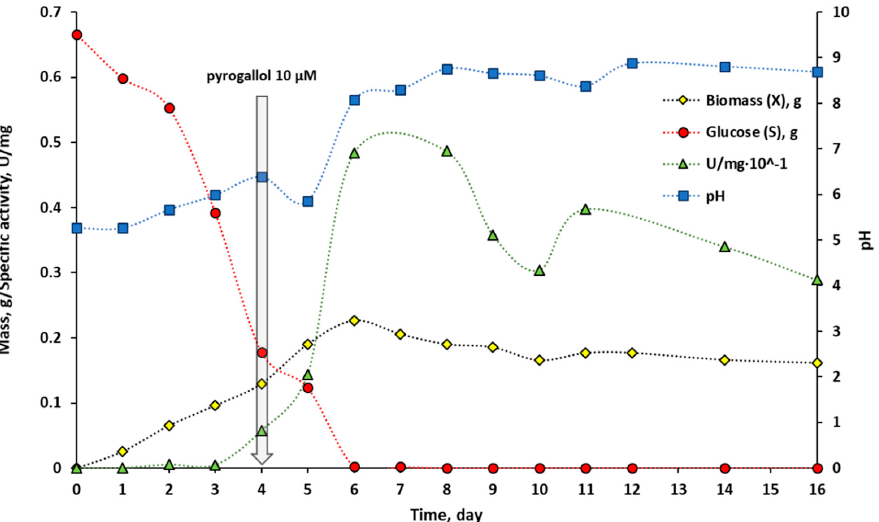
Figure 8. The course of Cerrena unicolor cultivation. The legend: yellow diamond—fungal dry mass [g], red circle—glucose (substrate) mass [g], green triangle—specific laccase activity [U/mg], blue square—pH in culture medium. The set of similar points was linked with a dotted line for clarity. The starting glucose mass was 0.63 g, on the 4th day the culture was induced with 10 µM of pyro- gallol.